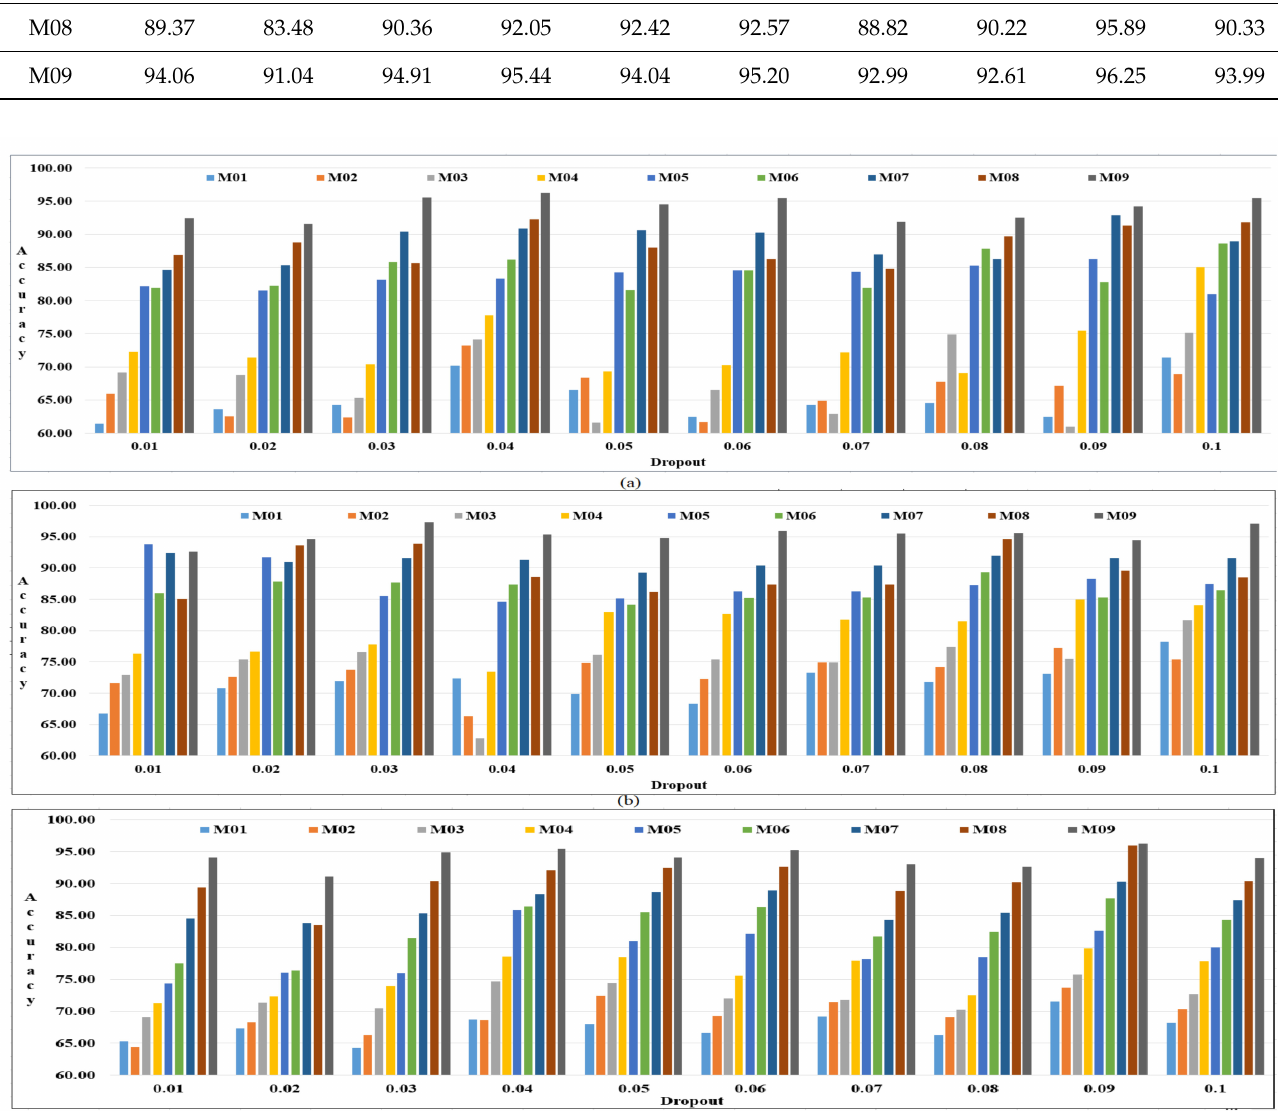
Figure 4. Average accuracy performance results for different embedding sizes: ( a ) embedding size of 200; ( b ) embedding size of 300; ( c ) embedding size of